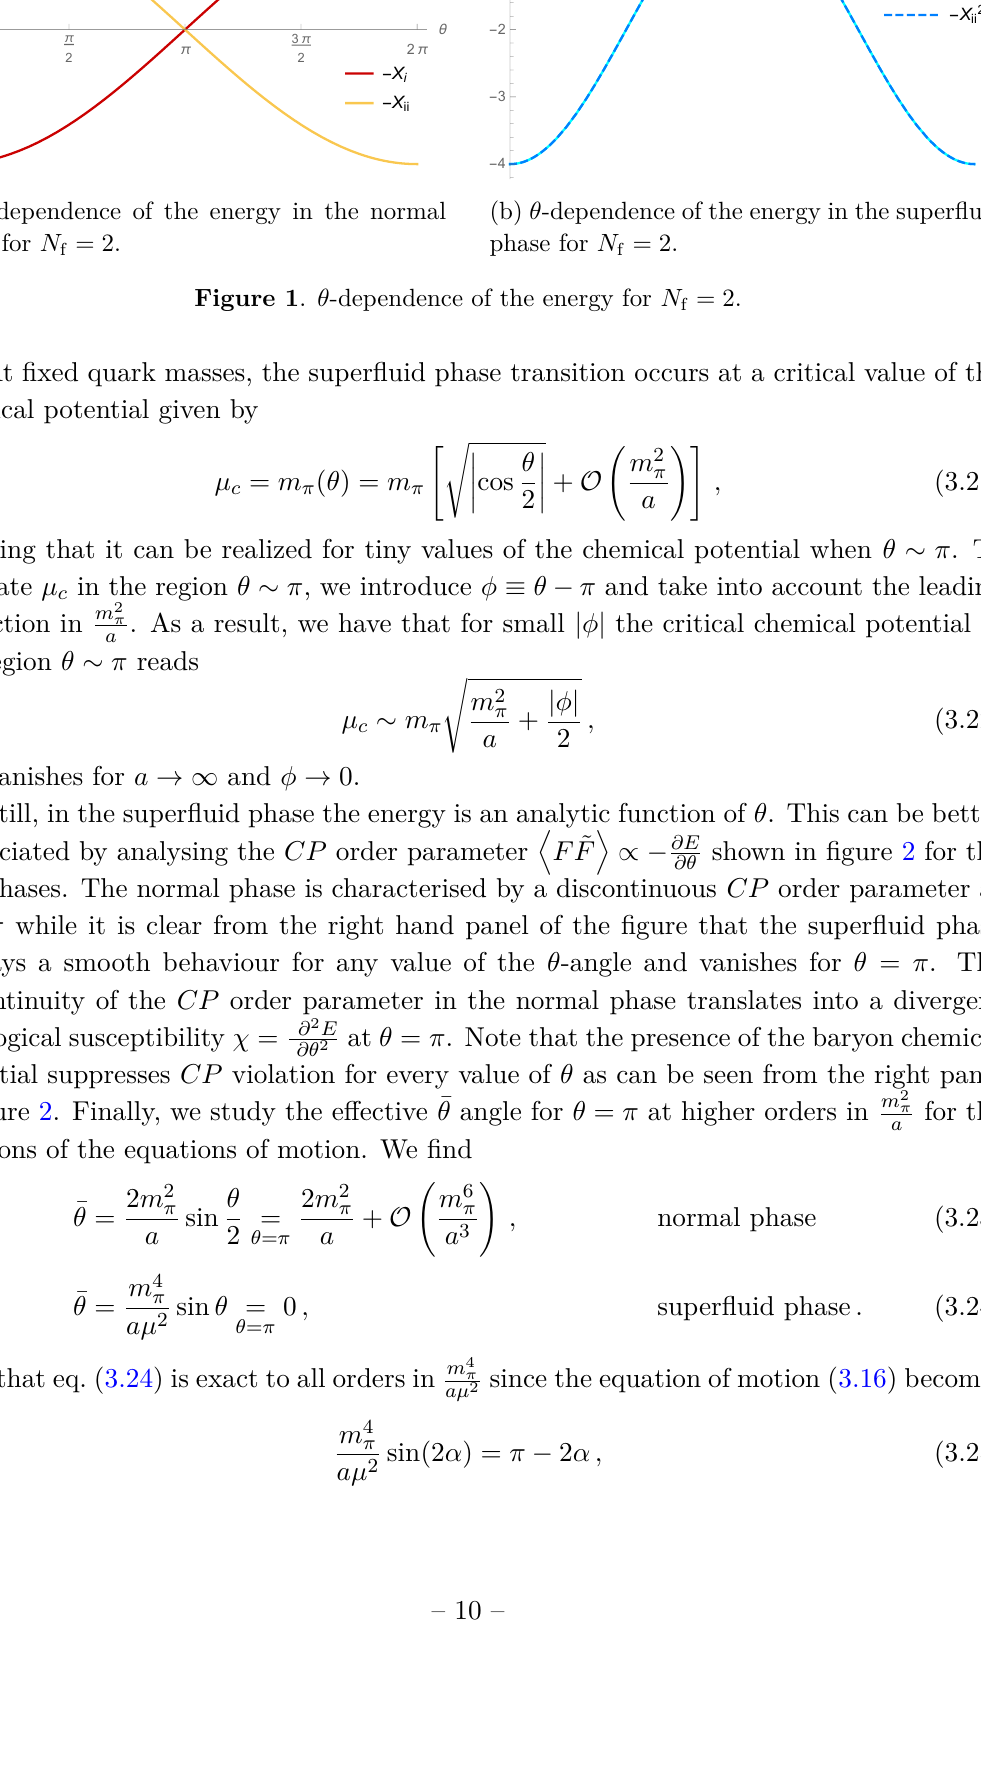
(b) θ -dependence of the energy in the superfluid phase for N = 2 . f